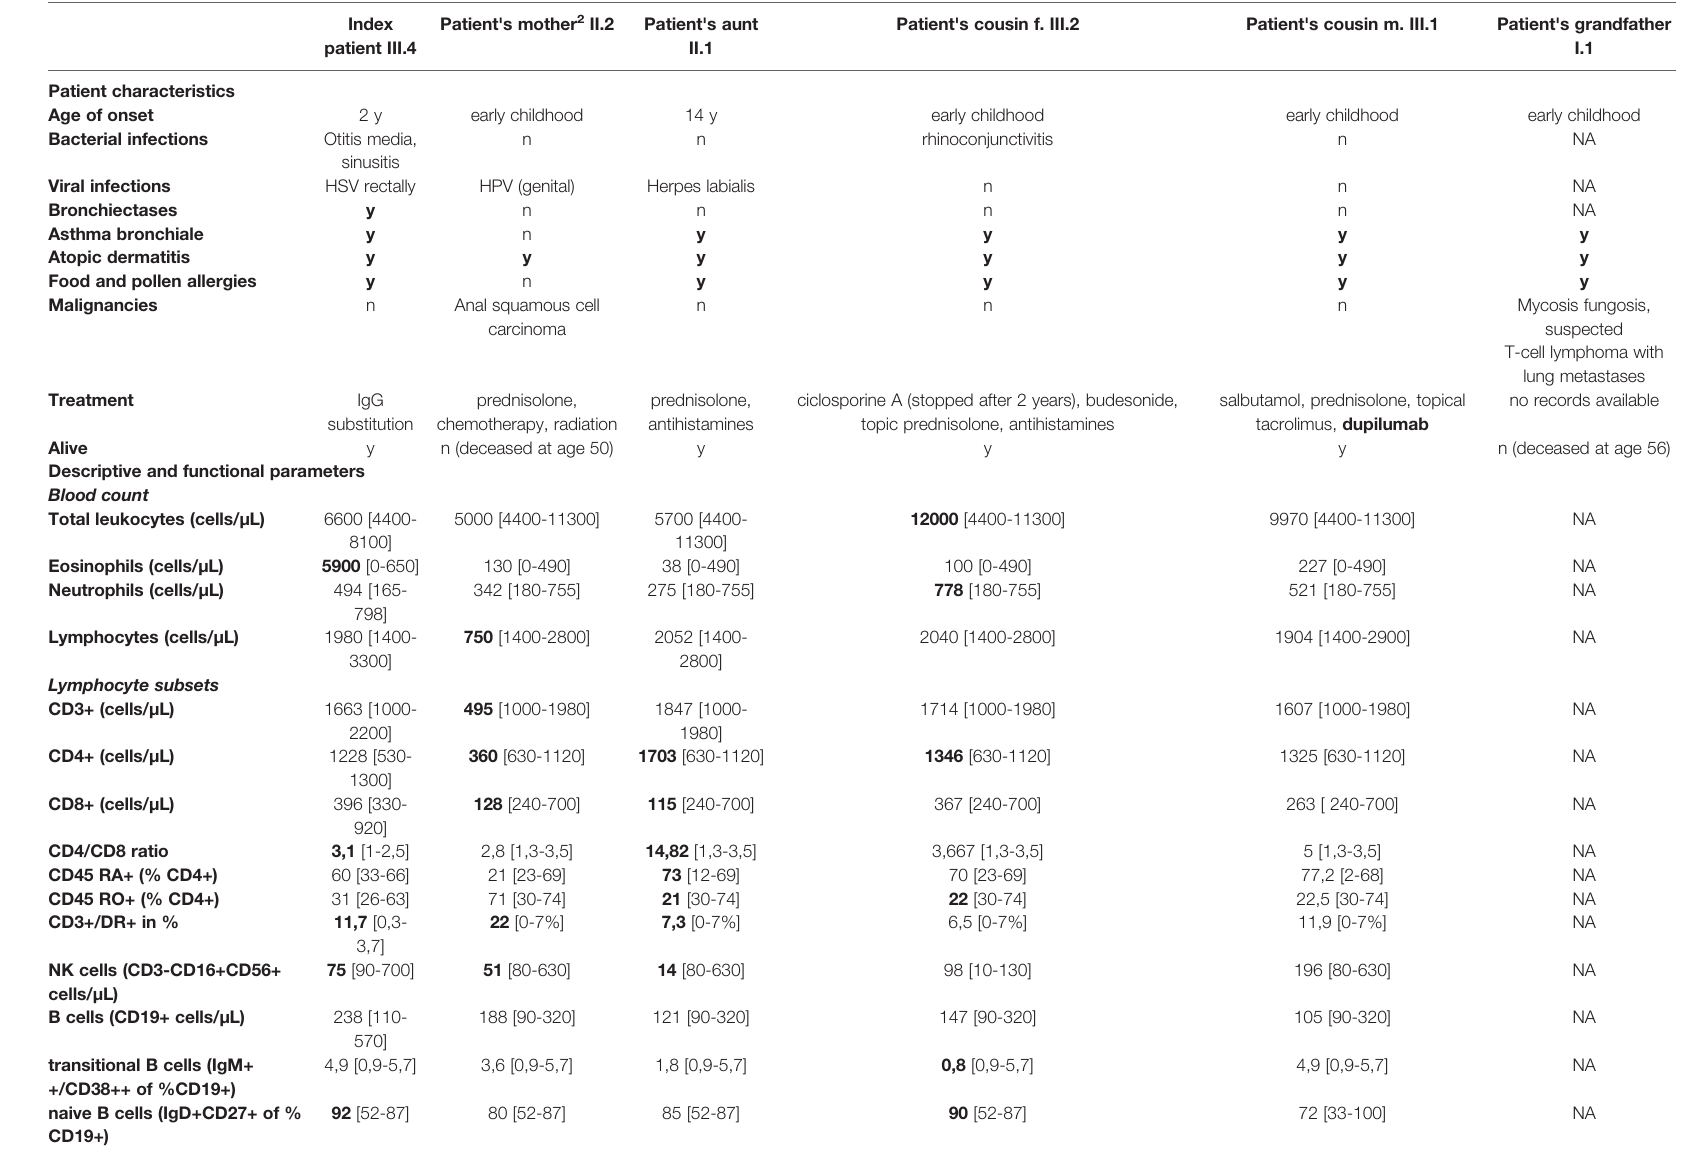
TABLE 1 | Summary of clinical and immunological